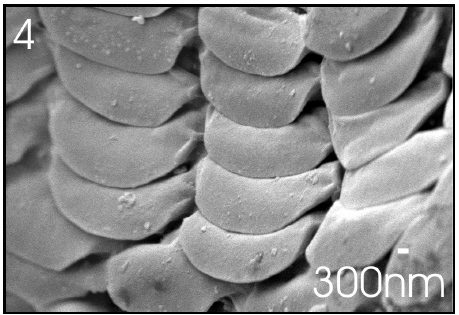
Fig. 4. The scales of the labrum did not reveal den- tate structures and matched the micrograph of Soler Cruz & Martin Mateo (2001) thus confirming the